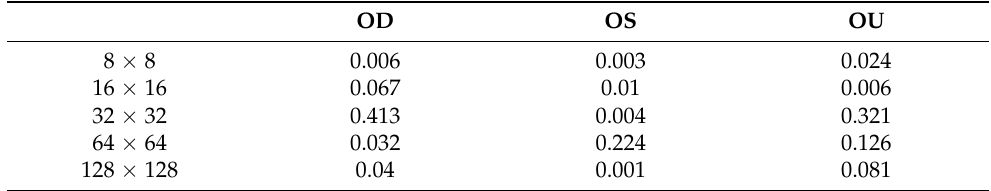
Table 2. VEP P1 p -values.